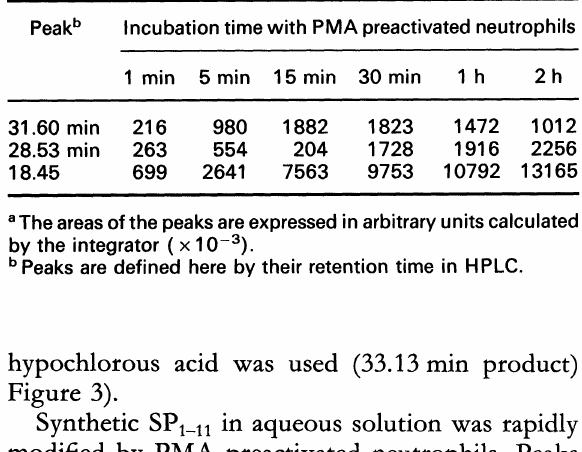
Table 1. Effect of PMA preactivated neutrophils on synthetic substance P. Human peripheral blood neutrophils (PMN) were isolated and preactivated by incubation in 50#g/ml PMA at 37C for 30 min. These preactivated cells were resuspended in ml RPMI-1640 medium to which mg/ml substance P was added. 100/1 aliquots were recovered at the times indicated and the cell free supernatant was analysed for substance P and its oxidation products using high performance liquid